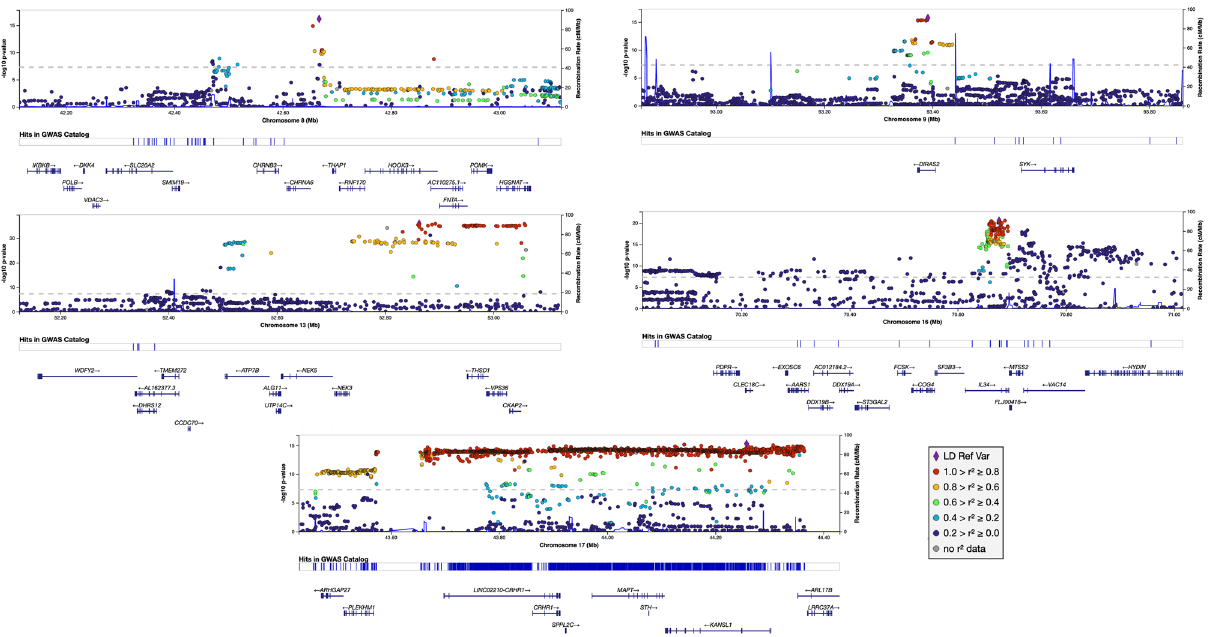
Figure 3. Regional association plots for significant loci in the GWAS performed in AD PRS extremes that had previously been implicated in AD in studies other than typical GWAS, but were not significant from the base AD